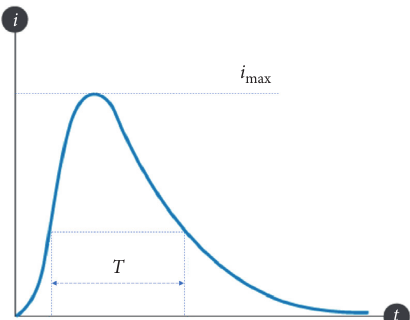
Figure 11: Characteristic time evolution of the current inside the xenon tube. Time constant T is in the order of 100 − 200 μ s for standard